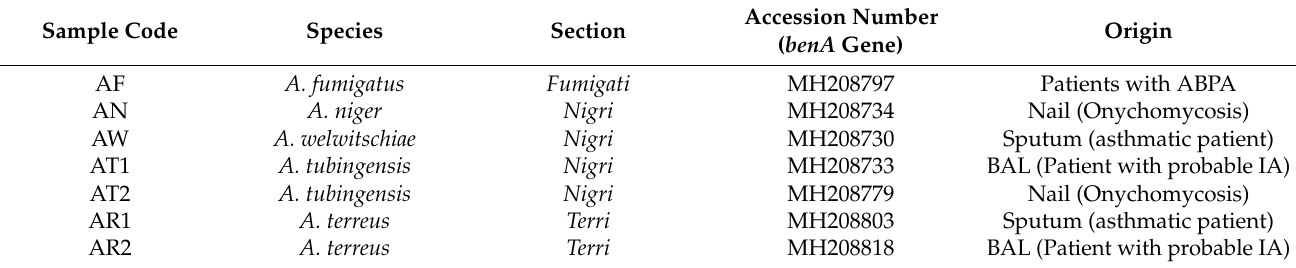
Table 1. The clinical source and accession number of